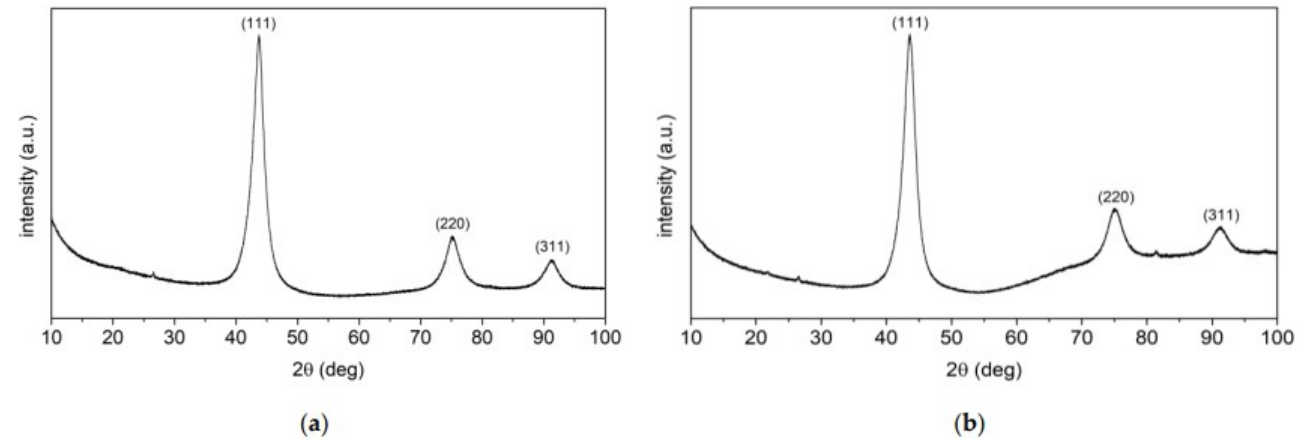
Figure 7. X-ray diffraction of detonation nanodiamond particles ( a ) pure detonation diamond nanoparticles DND); and ( b ) plasma ‐ chemically modified detonation diamond powder (MDP1).